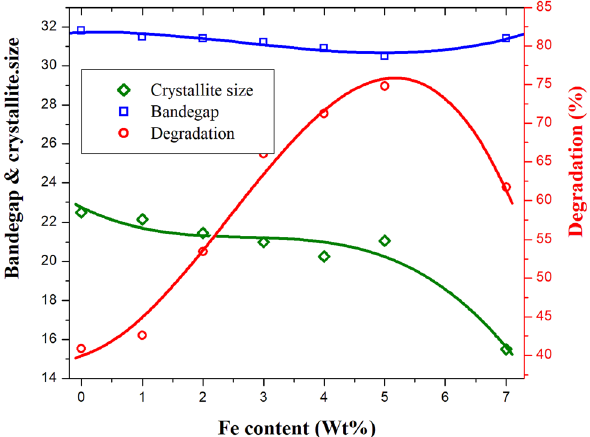
Figure 9: E ff ect of Fe content on bandgap, crystallite size, and MO degradation. The photodegradation was carried out under solar irradiation for 45 min.